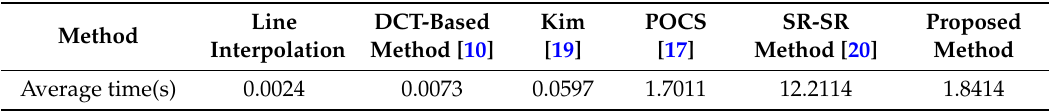
Table 5. Average execution time of different methods for all datasets (single HR